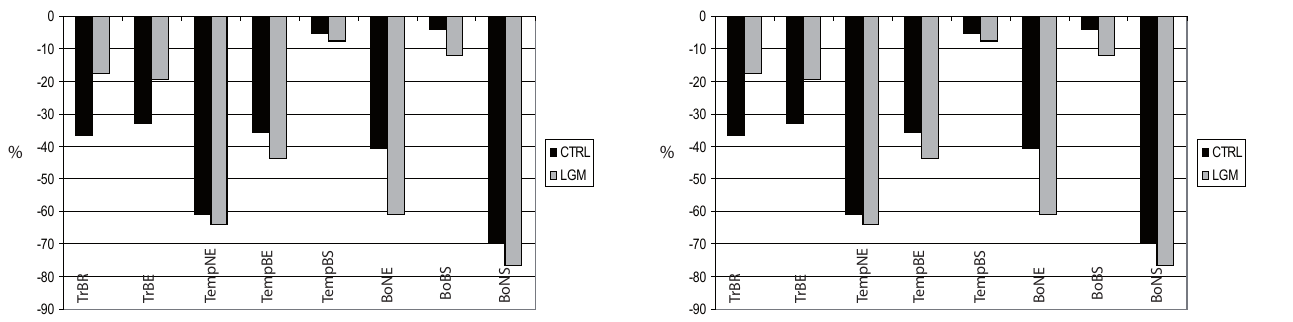
Fig. 13. Percentage of change in the area of presence of the tree PFT (fraction exceeds 1%) when the CO 2 is decreased from 310 to 185ppm and the background climate is kept constant to CTRL present or LGM. Abbreviations: see Table 1.